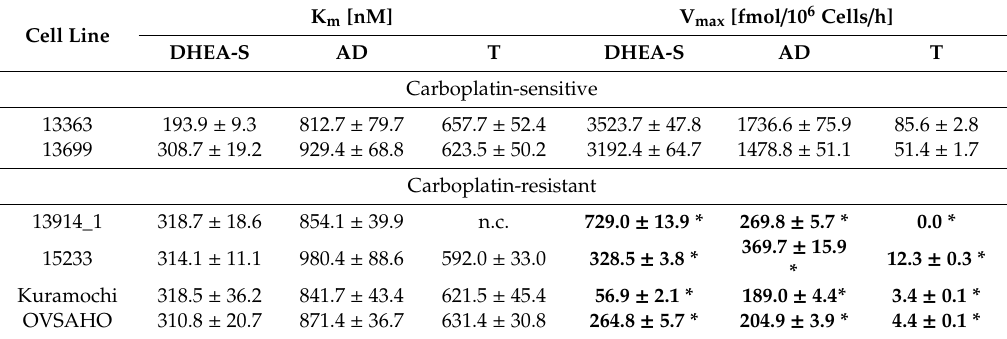
Table 1. Kinetic parameters of DHEA metabolism by the investigated HGSOC cells. K m and V max values were calculated using GraphPad Prism 6.0 software following the incubation of the cell lines with increasing concentrations of DHEA (0 to 2000 nM) as a hormone precursor for 48 h. All data are presented as the means ± SD of three independent experiments. Values in bold and marked with an asterisk ( * ) are significantly di ff erent as compared with both carboplatin-sensitive cell lines 13363 and 13699 ( p < 0.05). n.c., not calculable.